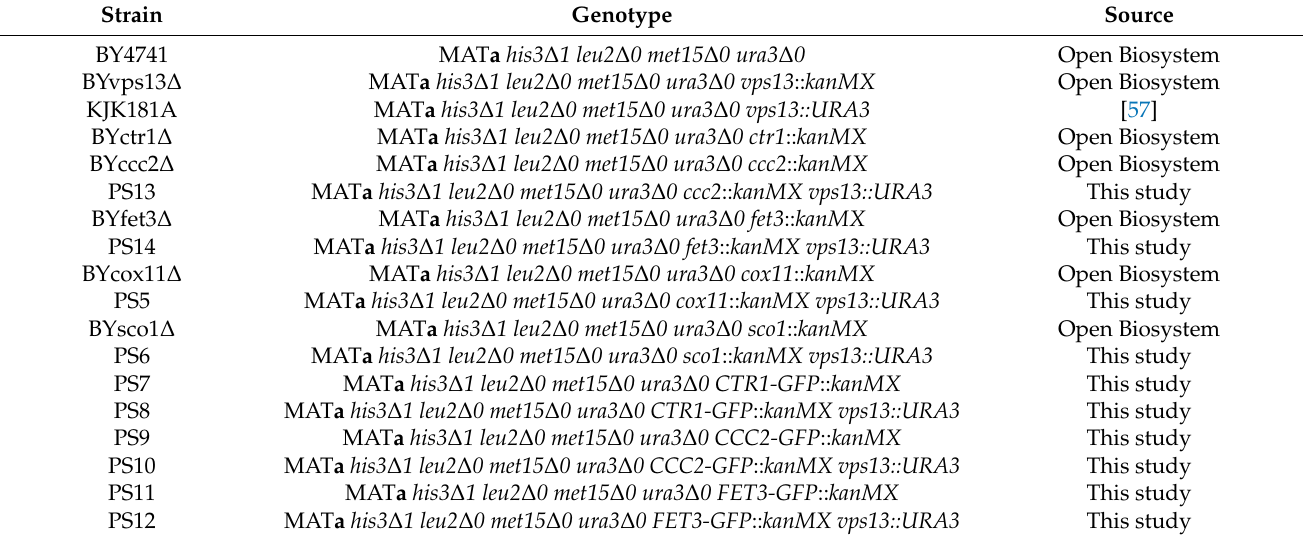
Table 1. Strains used in this study.